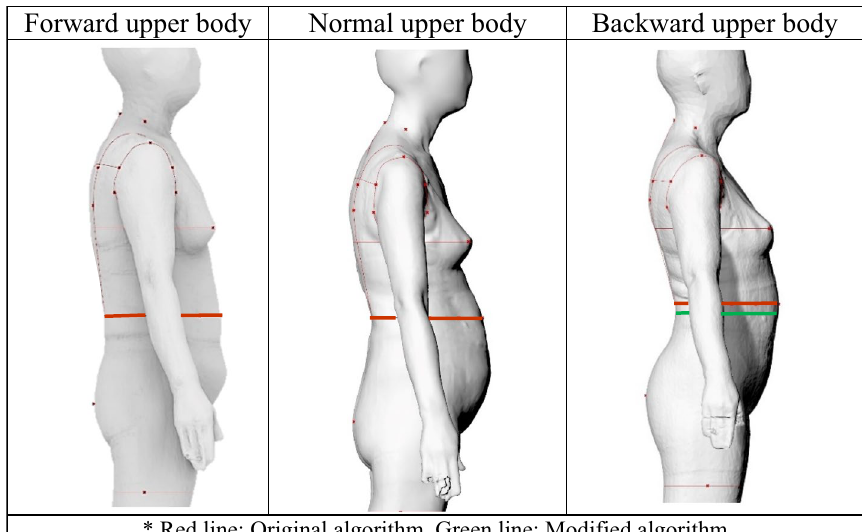
Fig. 10 The waistline identified by the